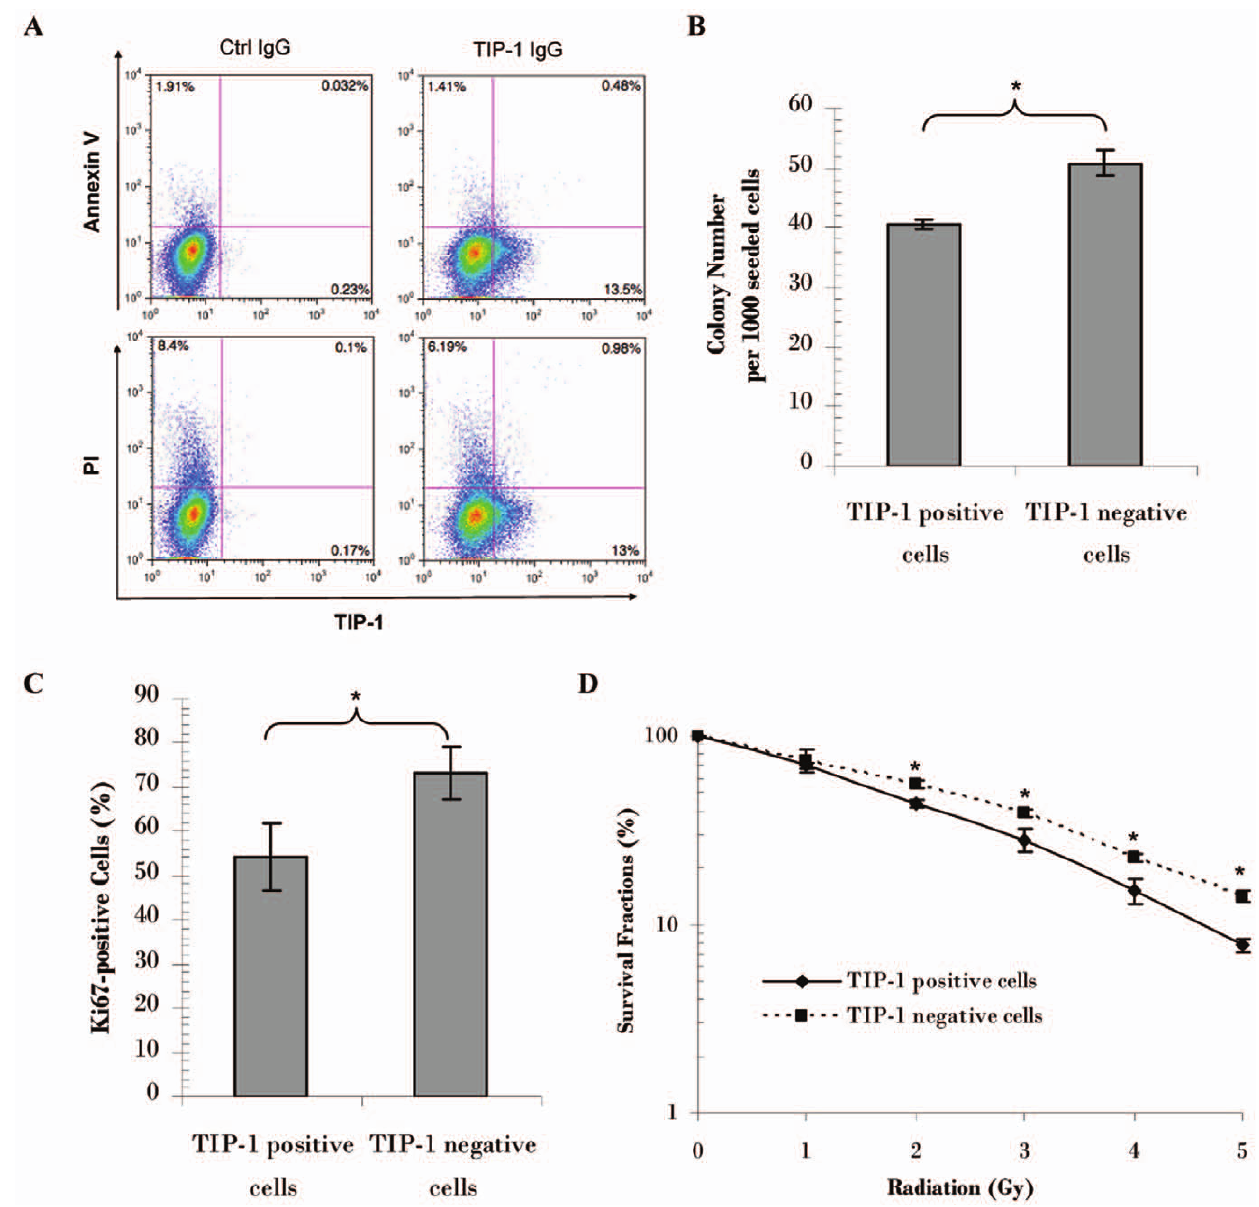
Figure 5. The TIP-1 translocation onto the cell surface is one biomarker other than those for the cell death and apoptosis. A: Flow cytometric profile of TIP-1 expression on the cell surface, apoptosis (Annexin V) and cell death or membrane integrity (PI) at 24 hours after the radiation (5 Gy) treatment of the H460 cells. Percentage of the cells in each section was shown in the representative profile images from three independent experiments. B : Colony formation on petri dishes of the TIP-1 positive and negative cells sorted from the irradiated H460 cells. The H460 cells were irradiated at 5 Gy. The TIP-1 positive and negative cells were sorted 24 hours post the radiation treatment. Colony formation capability of the two subgroups of cells was shown as colony number per 1000 seeded cells. C : Proliferation capability of the sorted cells as determined with Ki-67 staining. Percentage of the proliferative cells among the counted cells was shown. D : Susceptibility of the sorted H460 cells to subsequent irradiation. Shown are data from clonogenic assays. Survival fractions were presented to show difference of the radiation susceptibility between the TIP-1 positive and negative cells. * P , 0.05, n =3, the Student’s t -test.